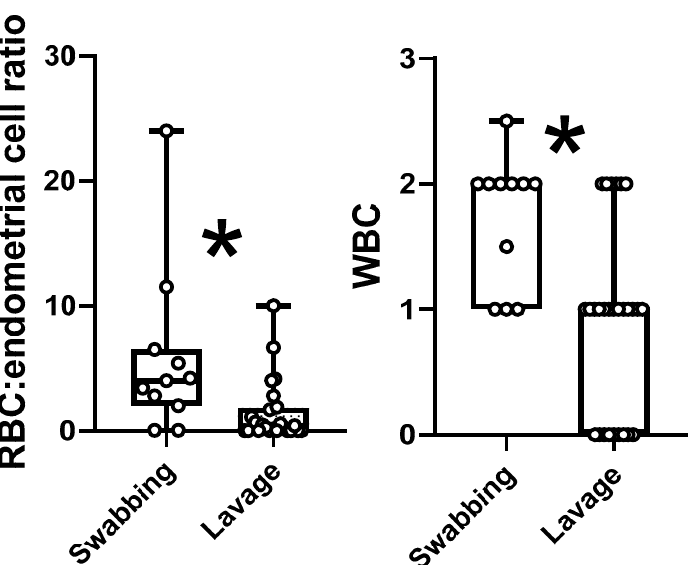
Figure 5. Red blood cells (RBCs): Endometrial cell ratio and white blood cell (WBC) numbers. * Samples obtained by uterine swabbing showed statistically significant ( p < 0.05) higher values for these two analyzed parameters in comparison with samples obtained by uterine lavage.